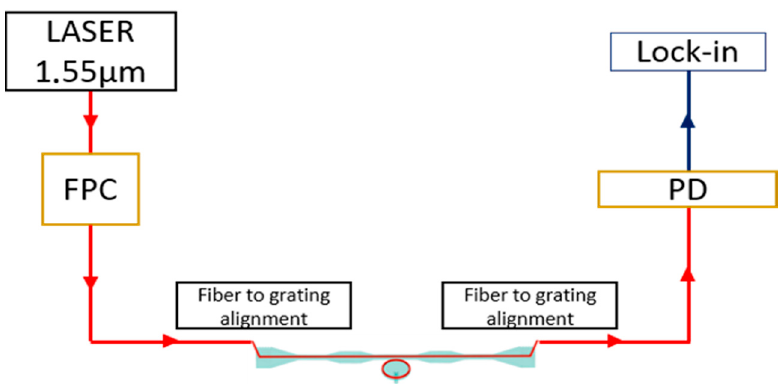
Figure 3. Schematics of the optomechanical setup.